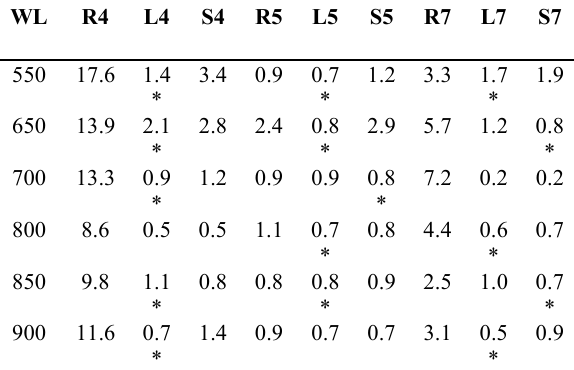
Table 4. The normalized root mean square errors of reflectance values comparing the reference spectral curve of verification targets with reflectance values extracted from the raw and fully corrected images. The normalization was performed by dividing the RMSE by interquartile range. The values are expressed as percentage. WL is wavelength in nanometres, R is raw data, L is laboratory calibrated data and S is in-situ calibrated data. The numbers define the calibration target. * marks lower NRMSE value in the corresponding pair of L and S.